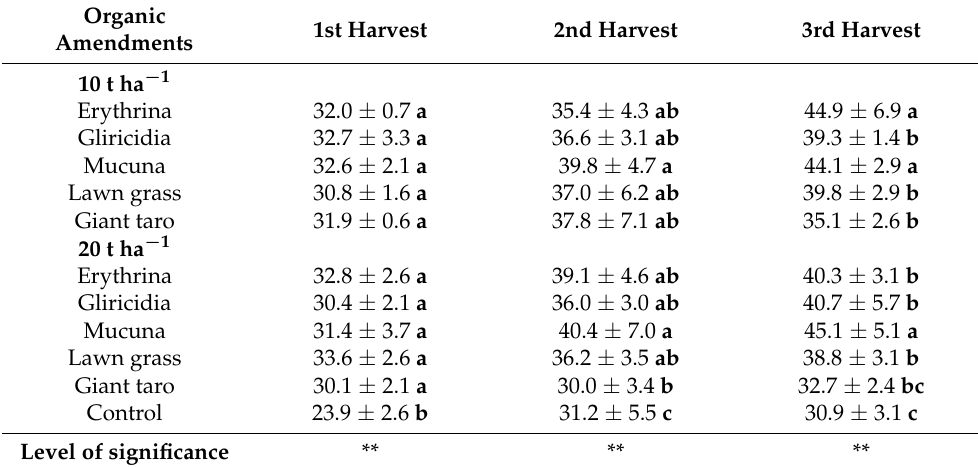
Table 5. Interaction effect of organic amendments with two application rates (10 and 20 t ha − 1 ) at three harvesting times (14, 28, and 42 DAT) on leaf chlorophyll content (SPAD) ( ± standard deviation) of Chinese